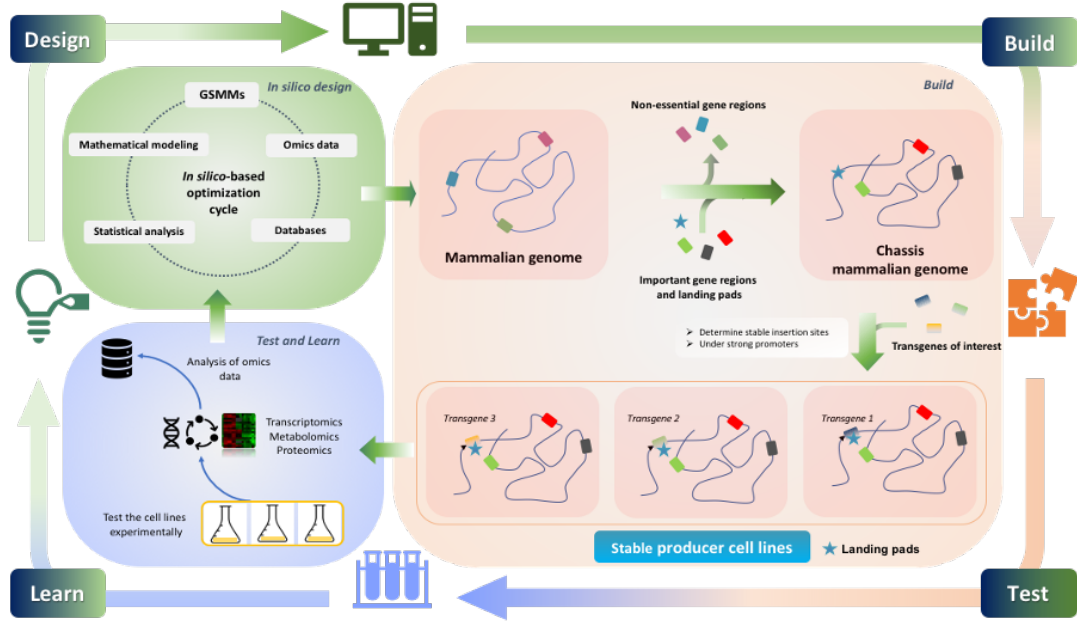
Figure 1. Steps towards creating a Chinese hamster ovary (CHO) chassis cell line. A combination of various in silico tools is used to predict intervention targets (e.g., for deletion or overexpression). A chassis cell line is constructed by performing genetic changes that boost growth or productivity and ensure desired product quality and stability. Various transgenes of interest can be inserted into a pre-defined landing-pad in the chassis cell line. Afterwards, the performance of the producer cell lines is validated experimentally and the results can be used to further optimize the chassis cell